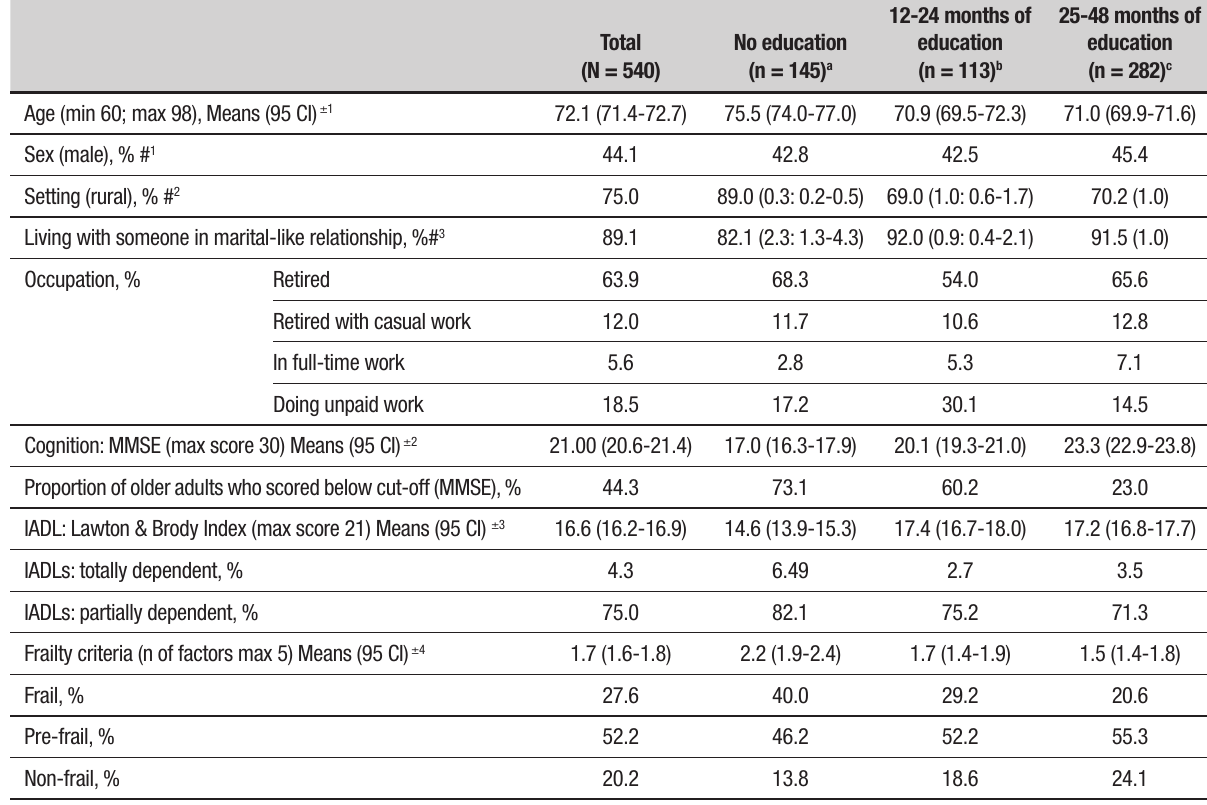
Table 1. Participants’ demographic characteristics and scores on cognition, activities of daily living, and frailty status, stratified by level of formal education in months (n = 540). São Carlos, Brazil, 2014.